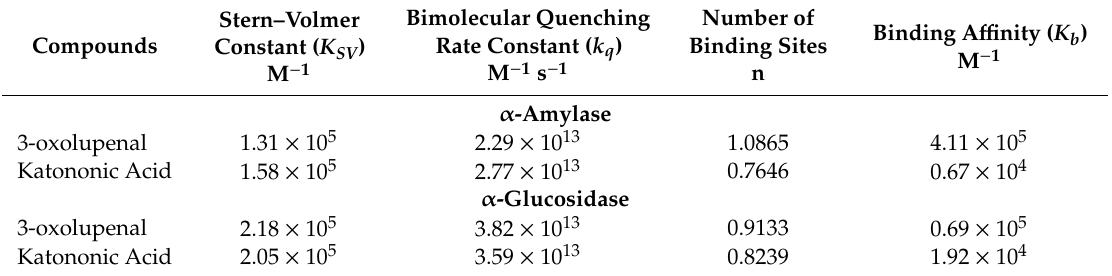
Table 3. Binding parameters of α -amylase and α -glucosidase with 3-oxolupenal and katononic acid.